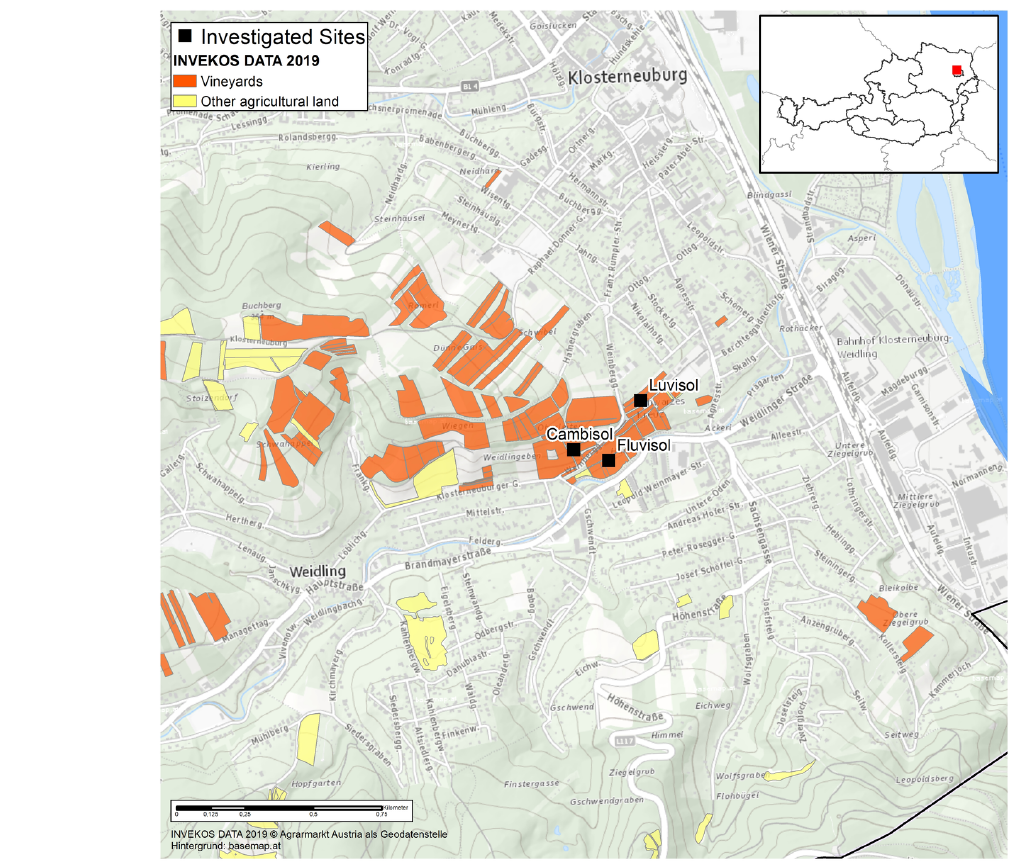
Figure 1. Geographical map of the investigated sites in Klosterneuburg, Austria. The study sites are marked by black squares. © INVEKOS DATA 2019. Agrarmarkt Austria als Geodatenstelle. Background: https://basemap.at (last access: 9 February